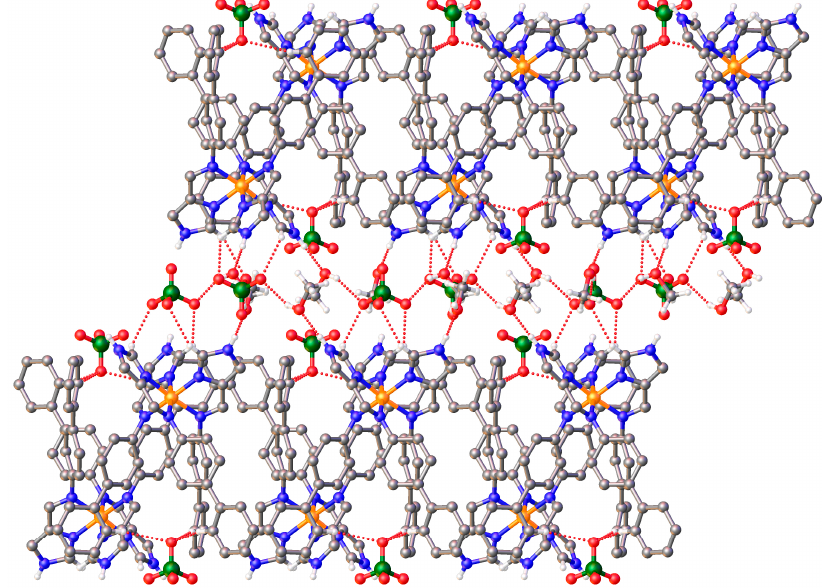
Figure 5. Side-on view of the 2D hexagonal planes and the ClO 4 -MeOH layer in 2 that links the planes.